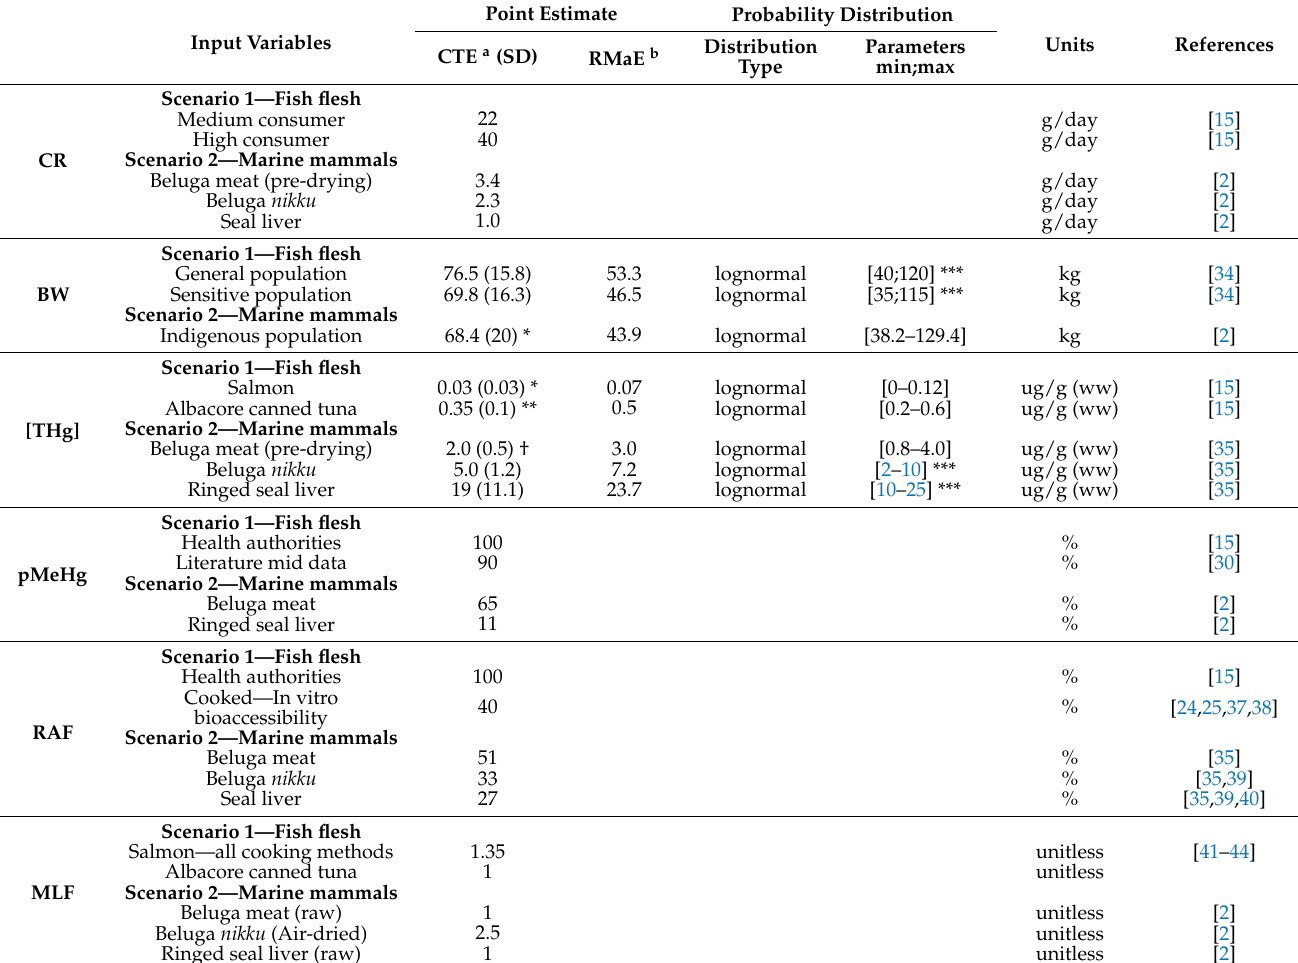
Table 1. Values used in the probabilistic risk